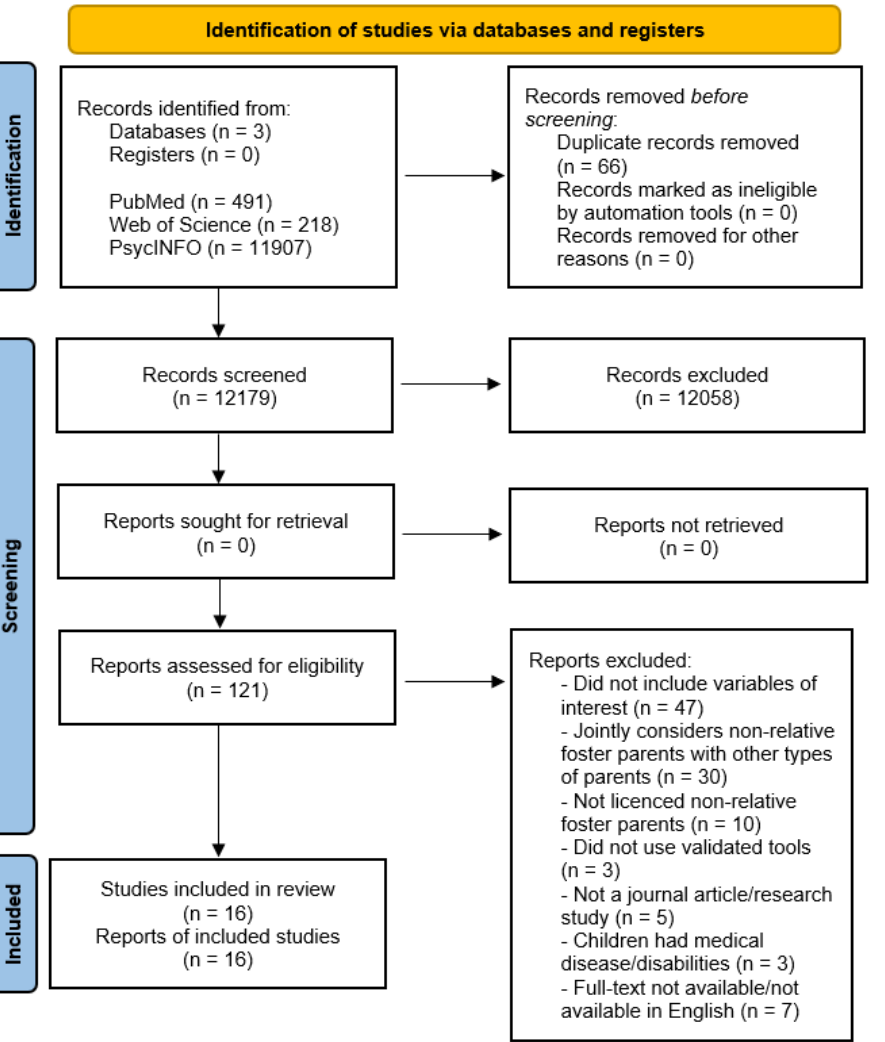
Figure 1. PRISMA 2020 flow diagram.